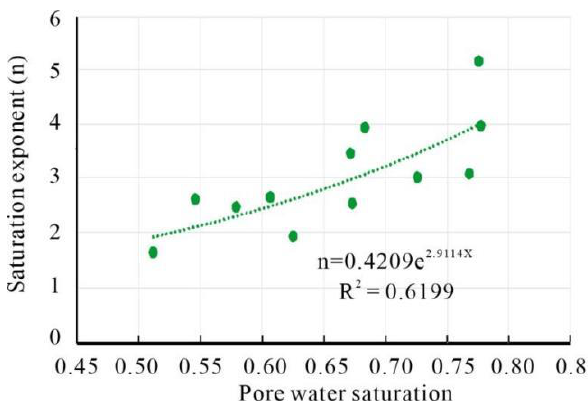
Figure 8. The saturation exponent versus connected water characteristics and the linear relationship between the saturation exponent and connected water characteristics, including the porosity in ( a ) and saturation of connected water in ( b ). R 2 is the correlation coefficient of the linear relationship.